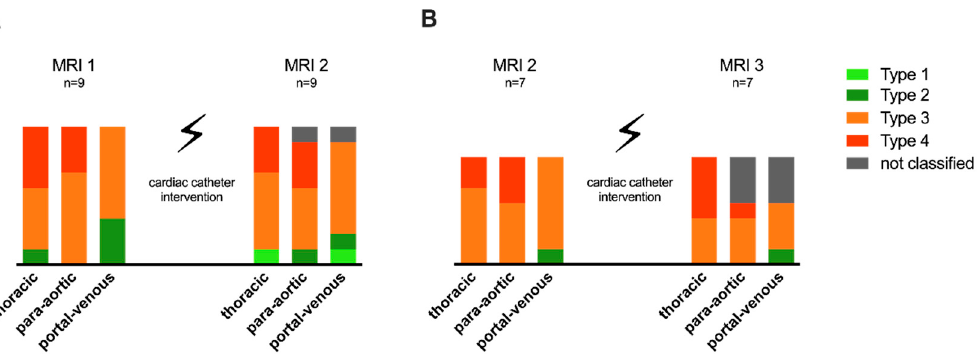
Figure 3. Changes in lymphatic abnormalities after hemodynamic intervention. ( A ) Changes in lymphatic abnormality classification between MRI 1 and 2: including nine patients. ( B ) Changes between MRI 2 and 3: including seven patients. Table 5. Correlation of cardiac catheterization data and lymphatic abnormalities.